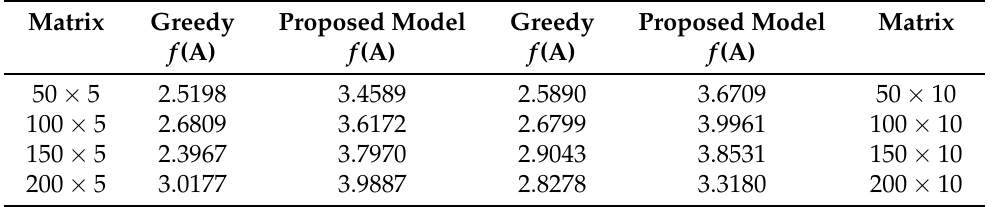
Table 3. Empirical results of the two methods implemented (the proposed model and the standard greedy